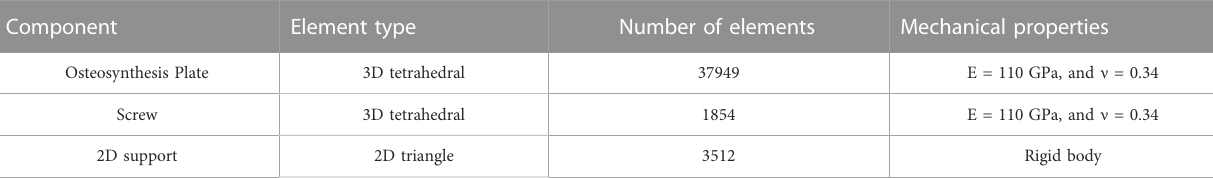
TABLE 1 Element type and mechanical properties (Elastic modulus and Poisson ’ s ratio) of different